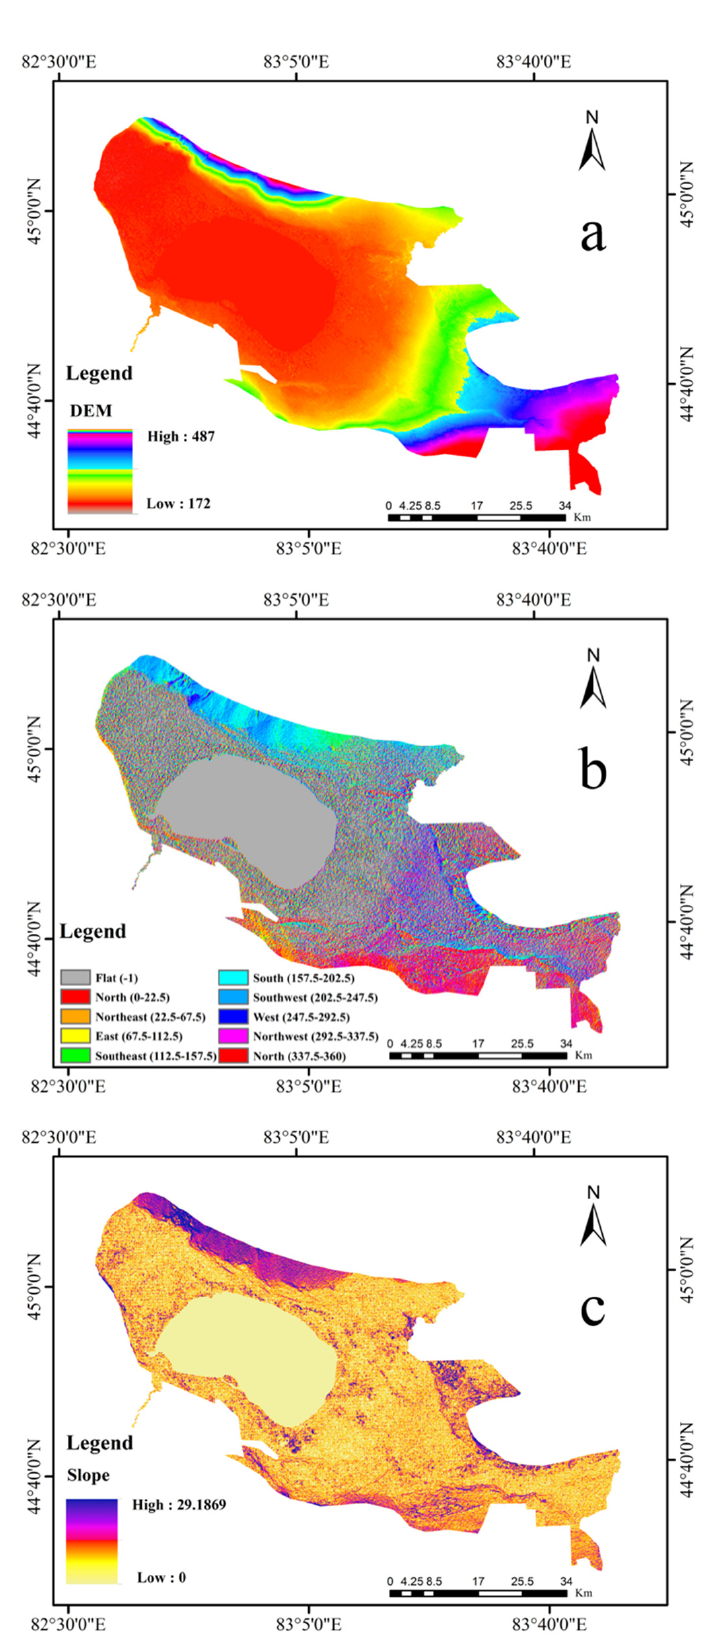
Figure 2. Topographic map of the study area: ( a ) The DEM data of the study area; ( b ) the surface aspect of the study area; and ( c ) the surface slope of the study area.